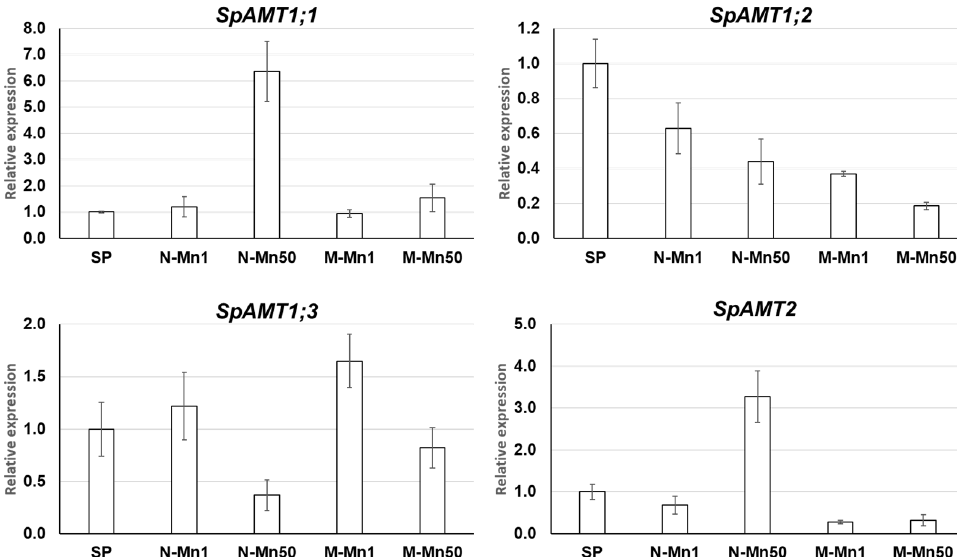
Figure 5. Expression patterns of the four SpAMT genes in duckweed cultivated in different media (N-Mn1, M-Mn1, N-Mn50 and M-Mn50). The gene expression was determined at cultivation day 4 by RT-qPCR relative to day 0, starting point (SP). Gene expression levels are in relative units. Error bars show ± SD of 3 replicates ( p < 0.05).